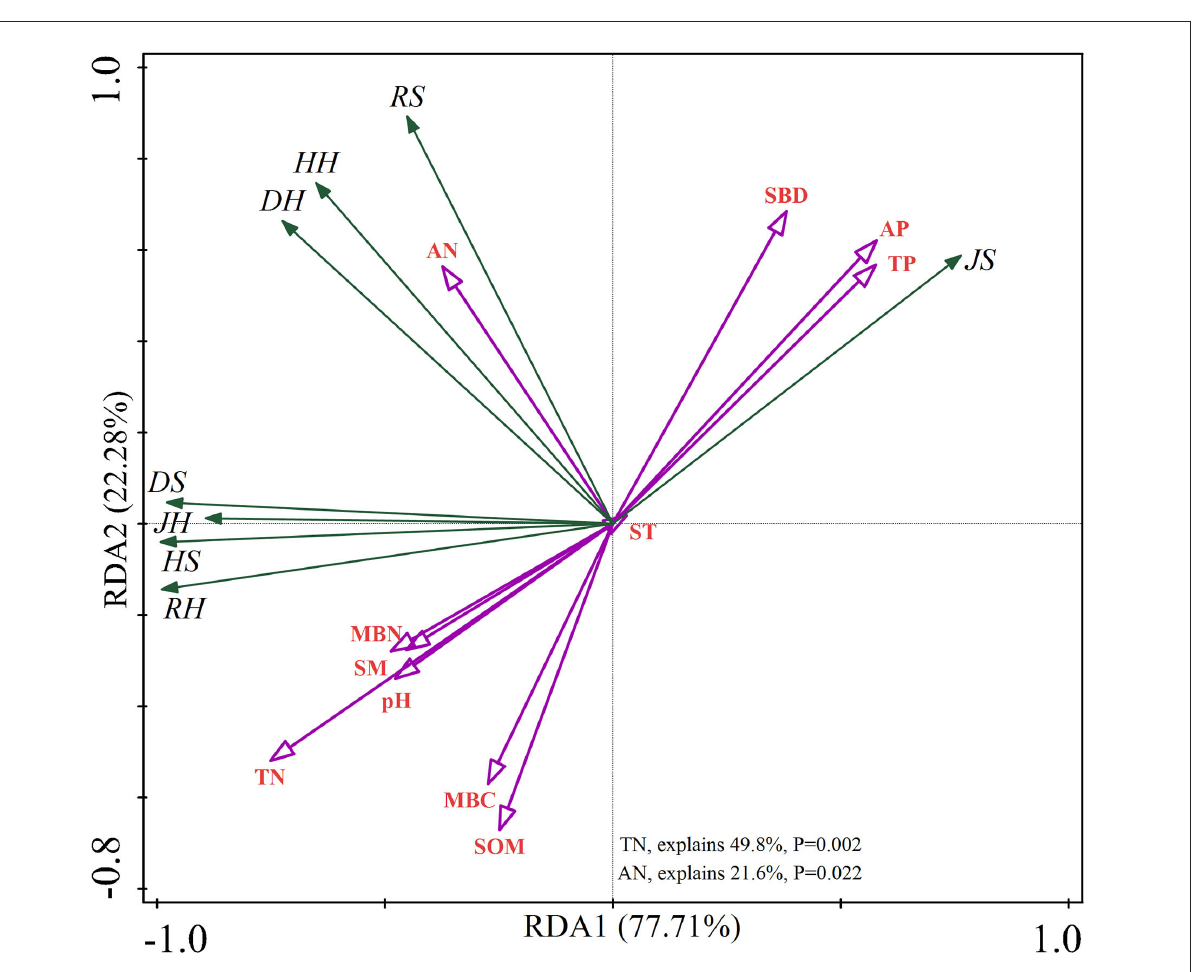
0.29%) ( p < 0.05; Figure 3A). At the order level, the relative abundance of Tepidisphaerales in the plots with forest gaps was significantly lower than that of the CK plots ( p <